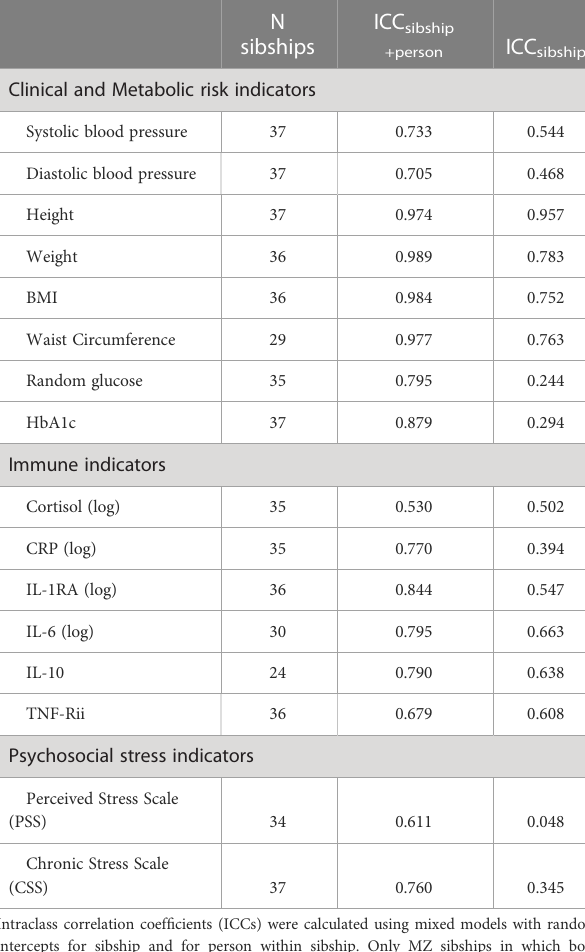
TABLE 2 Correlations in diabetes risk and stress measures among complete monozygotic twin pairs: Correlations of self-over-time and